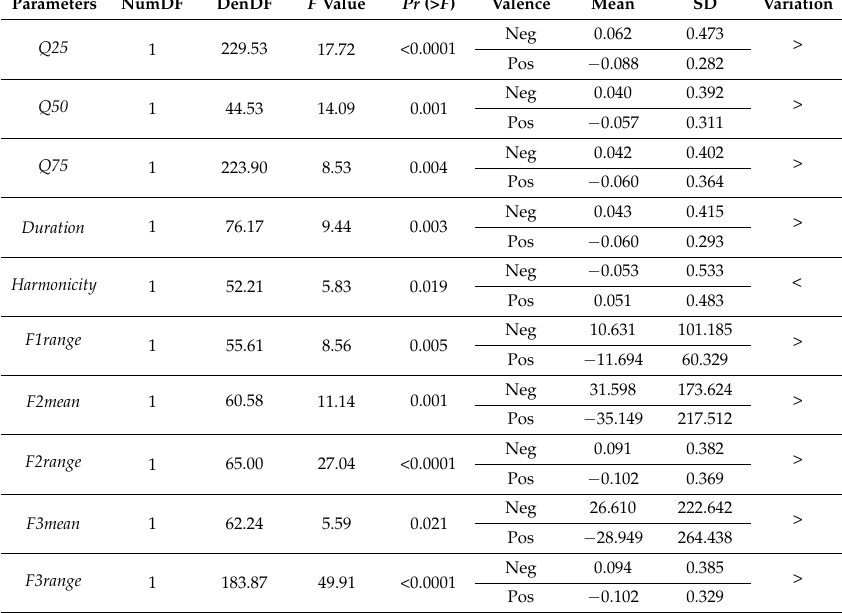
Table 4. Effect of valence attributed to the recording situations on the measured acoustic parameters (only significant values are shown). Residuals of the models controlled for the following factors: sex, age, size of the group, and type of call (see Supplementary Table S1 for raw values). The direction of the effect is displayed (< denotes an increase from negative to positive valence; > denotes a